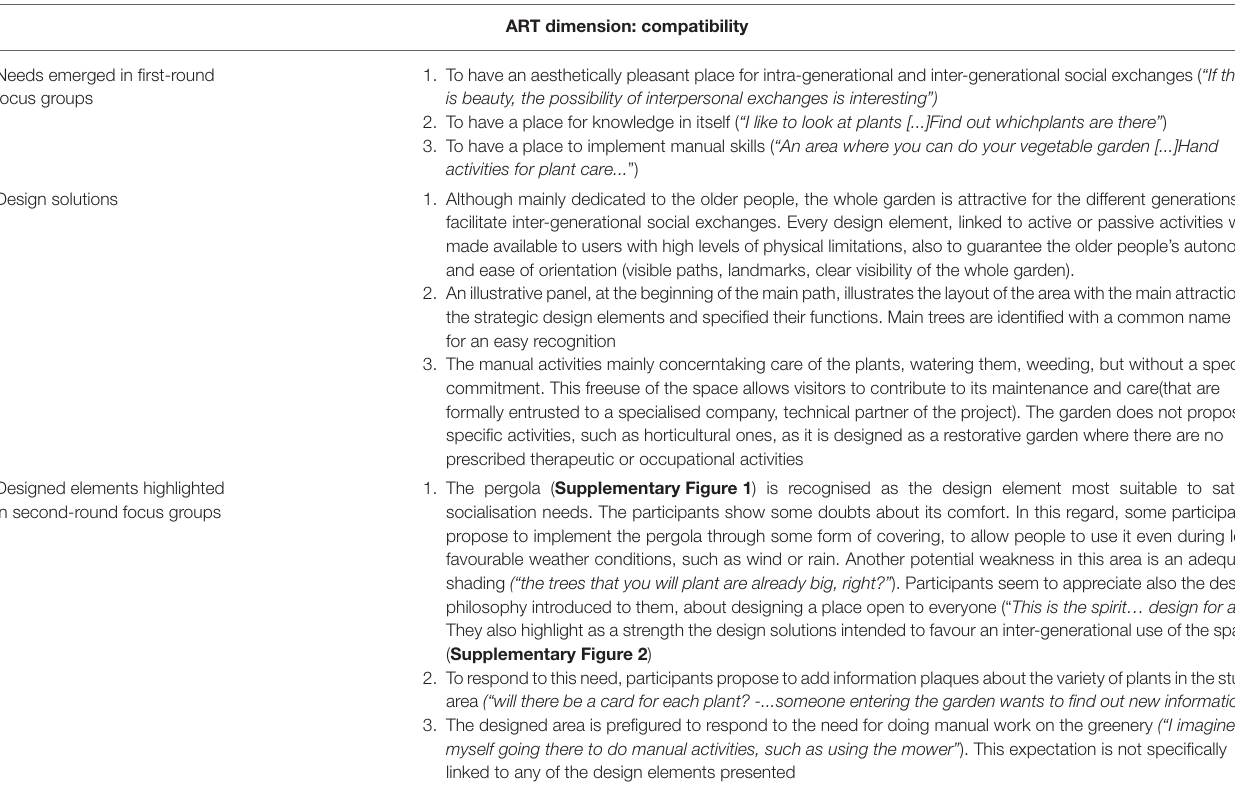
TABLE 2 | Comparison of the needs and reactions of the participants to the design proposal [attention restoration theory (ART), compatibility]. ART dimension: